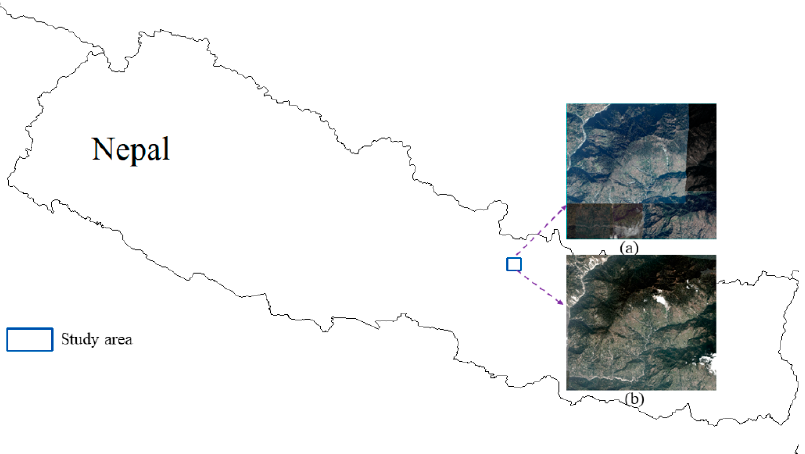
Figure 7. Experimental image in Central Nepal: ( a ) image captured on 12 December 2014; ( b ) image captured on 9 November 2015.